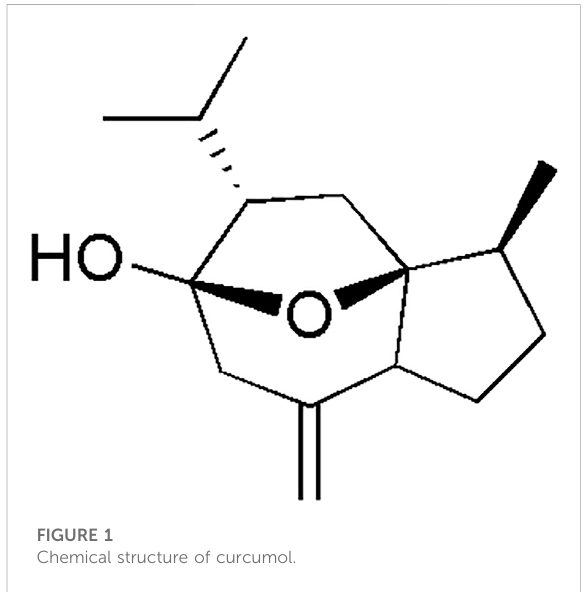
FIGURE 1 Chemical structure of